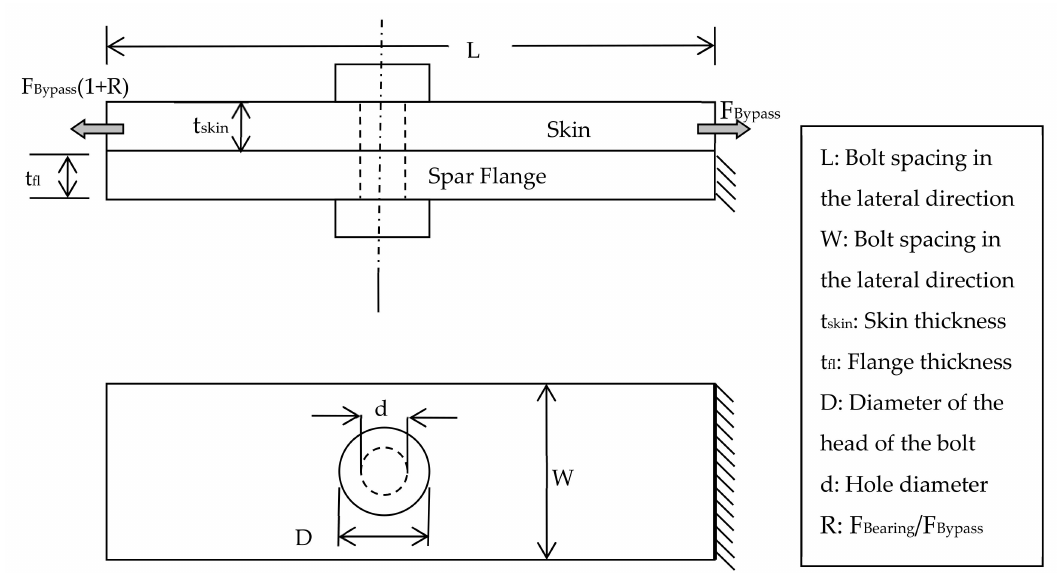
Figure 4. Dimensions of a bolted joint (the case of the skin-spar flange connection of a wing